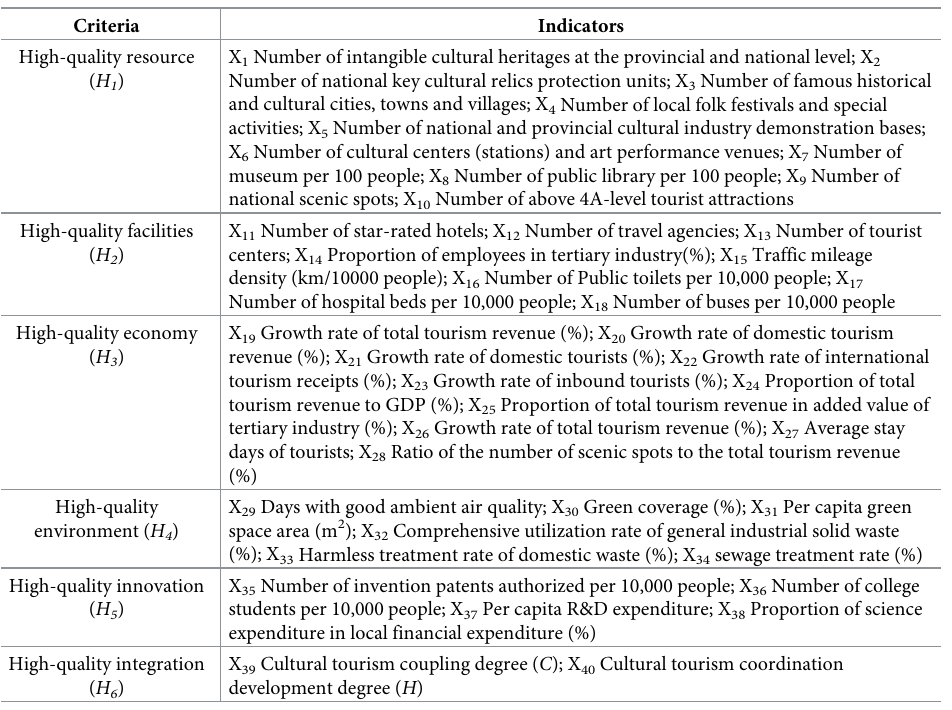
Table 1. The evaluation index system of